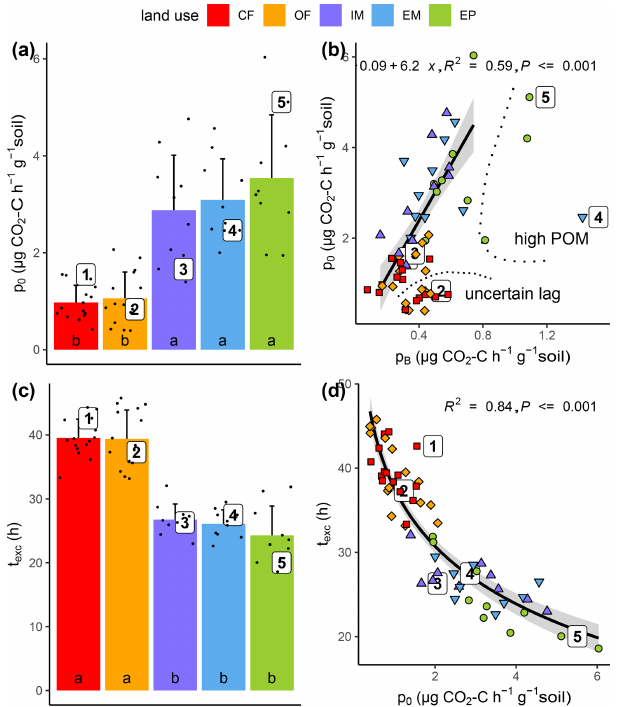
Figure 5. Initial substrate-induced respiration prior to growth ( p o ) as a function of (a) land use and (b) basal respiration ( p B ) as well as time until capacity excess of the respirometer ( t exc ) as a func- tion of (c) land use and (d) substrate-induced respiration ( p o ). High POM and uncertain lag in (b) indicate the samples that have been excluded from regression analysis. Different letters in bar plots (a, c) indicate significant differences ( p< 0 . 05) between land use